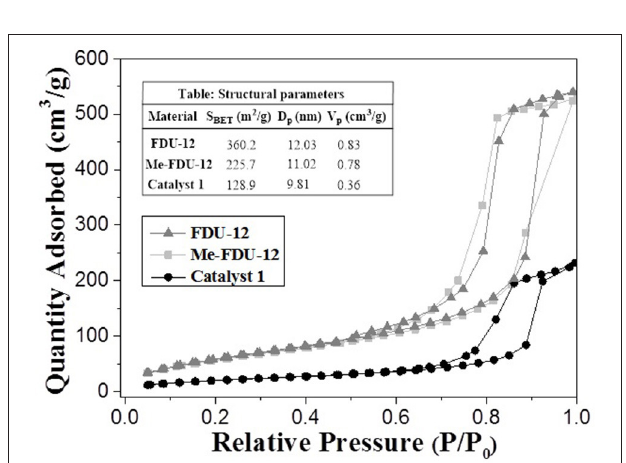
FIGURE 2 | The solid–state 13 C CP/MAS NMR spectrum of catalyst 1 .